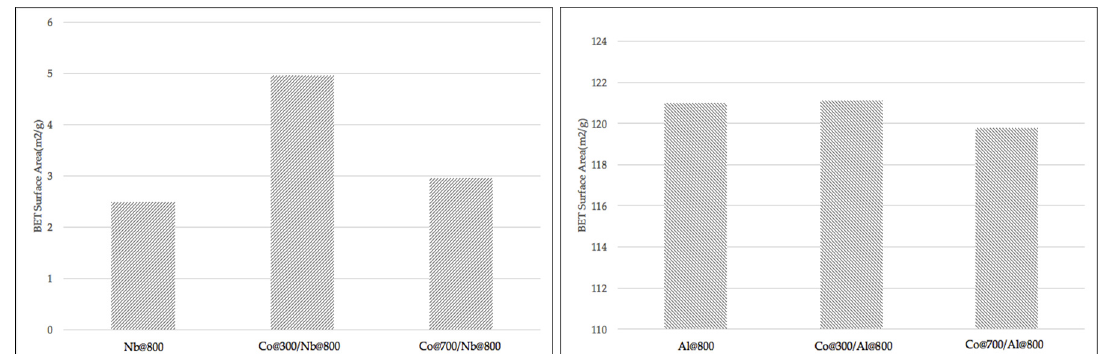
Figure 10 . Comparison between Co 3 O 4 /Nb 2 O 5 and Nb 2 O 5 ( left ); comparison between Co 3 O 4 /Al 2 O 3 and Al 2 O 3 ( right ). BET test was conducted on Quantachrome ChemBET Pulsar TPR/TPD, carrier gas is 30% N 2 /He.